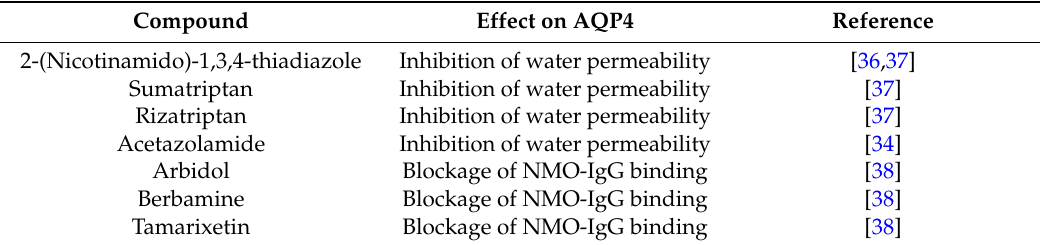
Table 1. Compounds known to inhibit water permeability of AQP4 and to block Neuromyelitis Optica (NMO)-IgG